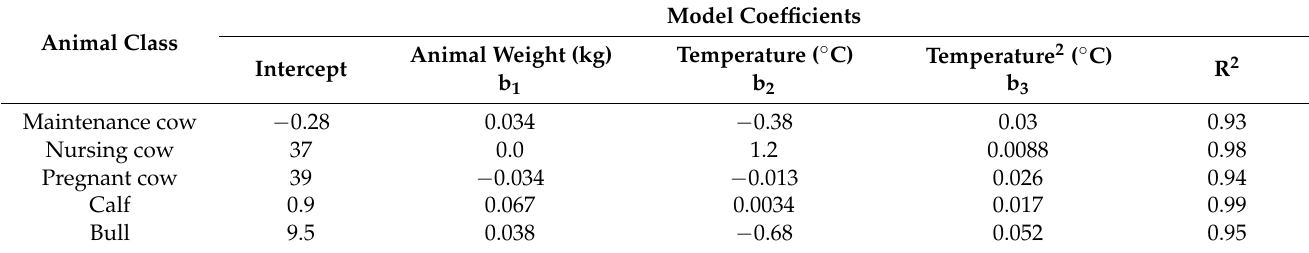
Table 3. Model coefficients for drinking water requirements during the cow-calf phase (Adapted from Beckett and Oltjen